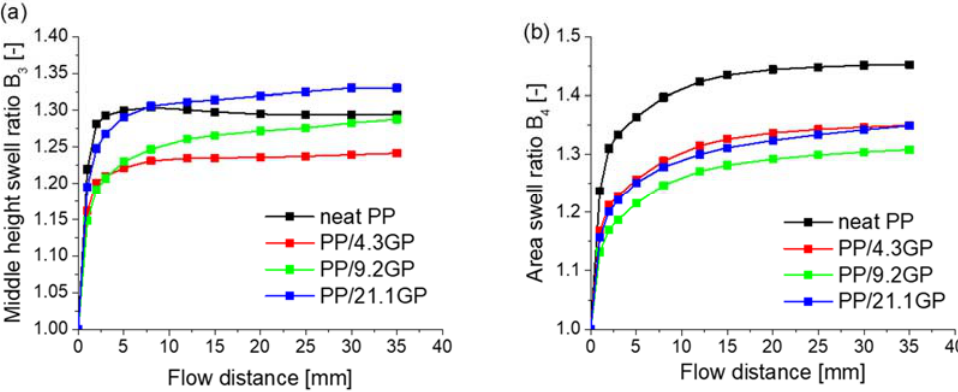
Figure 8. Comparison between the evolution of the simulated middle height swell ratio B 3 ( a ) and area swell ratio B 4 ( b ) for PP melt with various filler contents at a flow rate of 620 mm 3 s − 1 .